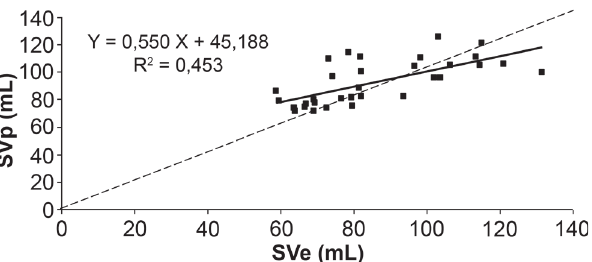
Fig 7. Correlation plots between SVe and SVp computed with the Liljestrand algorithm. —— : equality line.